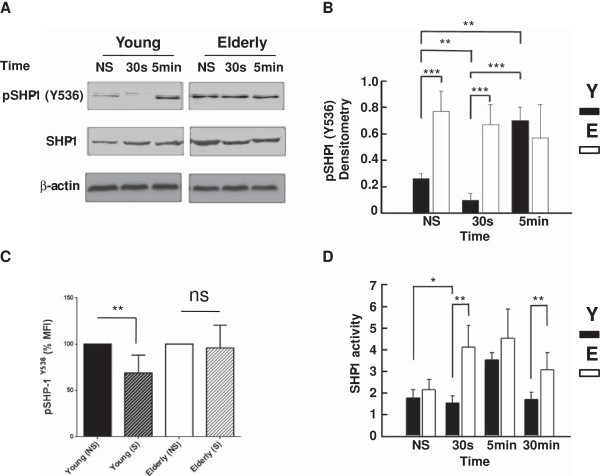
Western blot analysis of the levels of (active) tyrosine-phosphorylated (Y536) SHP-1. (A) Purified T cells of young and elderly donors were left non-stimulated (NS) or exposed to a mixture of anti-CD3 and anti-CD28 (5 μg/ml each) mAbs for 30 s or 5 min, as indicated. Cell lysates were sized by SDS-PAGE under reducing conditions, electrotransfered to nitrocellulose membranes and proteins revealed using an anti-Y536 SHP-1 mAb and the chemiluminescence technique. β-Actin was used as control of gel loading. The protein transferred to nitrocellulose membranes were stained with Ponceau to verify that similar amounts of protein had been loaded in each lane. (B) Semi-quantitative densitometric analysis of protein bands of young (filled columns) and elderly (empty columns) donors reported in arbitrary units. Data are represented as the mean ± SD and are representative of one of 20 independent experiments. (C) Flow cytometry measurements of pSHP-1-Y536 MFI in T cells of young and elderly subjects at non-stimulated (NS) and stimulated for 30 seconds (S) states as decribed in the Materials and Methods section. The non-stimulated is normalized as 100% and significant difference is shown by **, p < 0.01. (D) Determination of SHP-1 activity in T cell lysate immunoprecipitate using 4-nitrophenyl phosphate as a substrate. Data show results of T cells of young (filled columns) and elderly (empty columns) donors reported in optical density units. Data are represented as the mean ± SD. Asterisks correspond to statistical significance (Student’s t-test) for p < 0.05 (*), p < 0.01 (**) and p < 0.001 (***). Data are representative of one of 20 independent experiments.